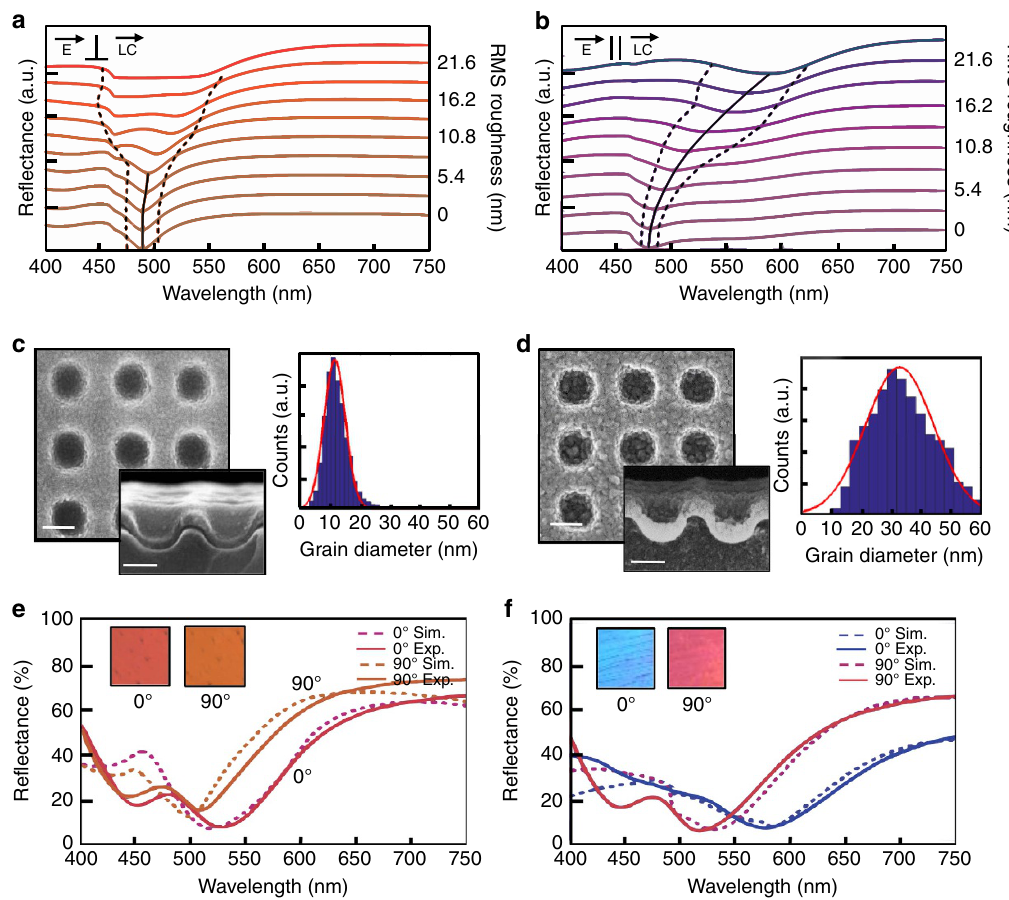
Figure 2 | Surface morphology induced polarization dependence. FDTD-computed reflection spectra of a 300nm period nanowell array with a 30nm aluminium film for ( a ) incident light polarized perpendicular to the liquid crystal director and ( b ) incident light polarized parallel to the LC director. Line colours are determined by the CIE colour matching functions. Dotted black lines outline the FWHM of the resonance while a solid black line traces the resonance location. ( c ) SEM images of a ‘smooth’ aluminium film and a corresponding grain size histogram while d depicts that of a ‘rough’ aluminium film. Experimental and simulated reflection spectra of the ( e ) ‘smooth’ and ( f ) ‘rough’ surfaces shown above. Scale bars, ( c , d ) 150nm. Solid lines are FTIR measured reflection spectra while dotted lines are histogram weighted FDTD spectra. Insets show microscope images of the surfaces and all line colours are determined by the CIE colour matching